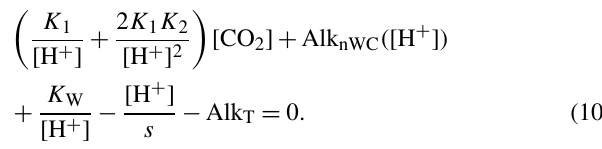
Figure 1. (a) pH; (b) HCO − and (c) CO 2 − concentration isolines in C T –Alk T space; (d) CO 2 , (e) HCO − 3 3 in pH–Alk T space. Blank areas in panels (d) , (e) and (f) represent the pH–Alk T combinations that lead to negative Alk C . The blue and black stars in panels (c) and (f) locate the two possible C T and pH roots for a sample with Alk T = 2 . 3mmolkg − 1 and [ CO 2 − (one of the dashed isolines, as indicated by the open star symbol in the colour scale). Figure 3 in Deffeyes (1965) is similar to panel (c)